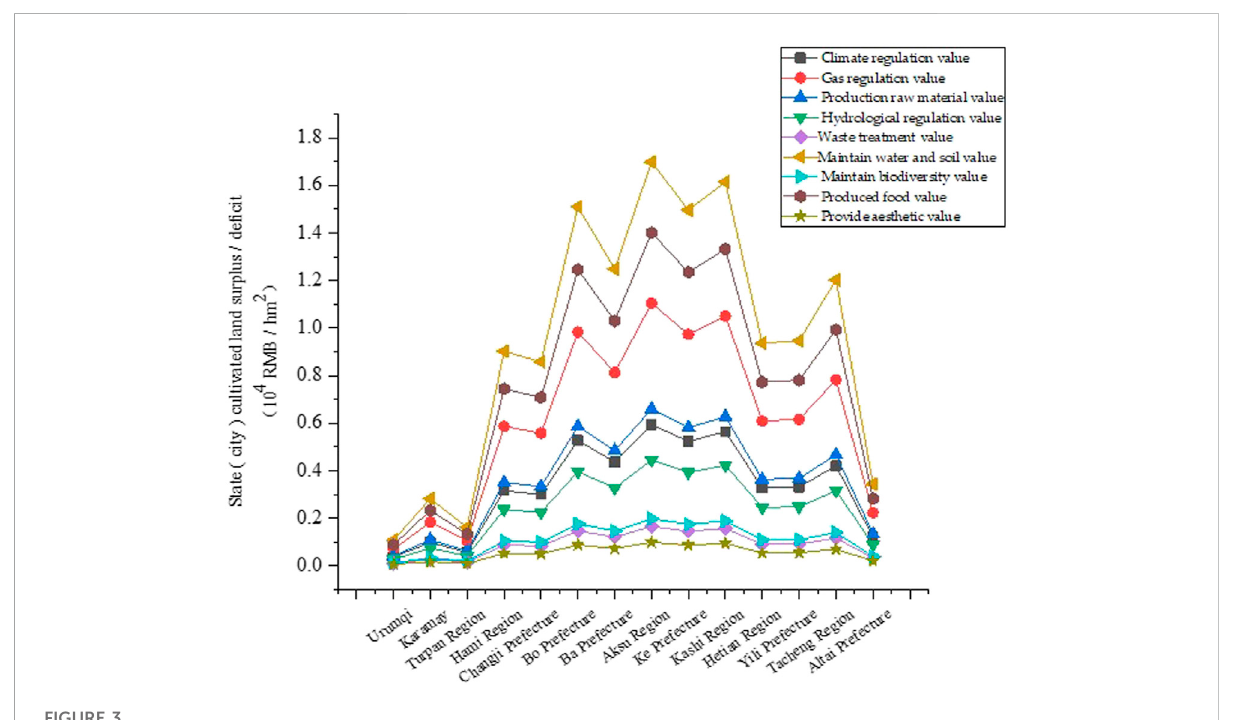
FIGURE 3 Positive ecological value of cultivated land in the state